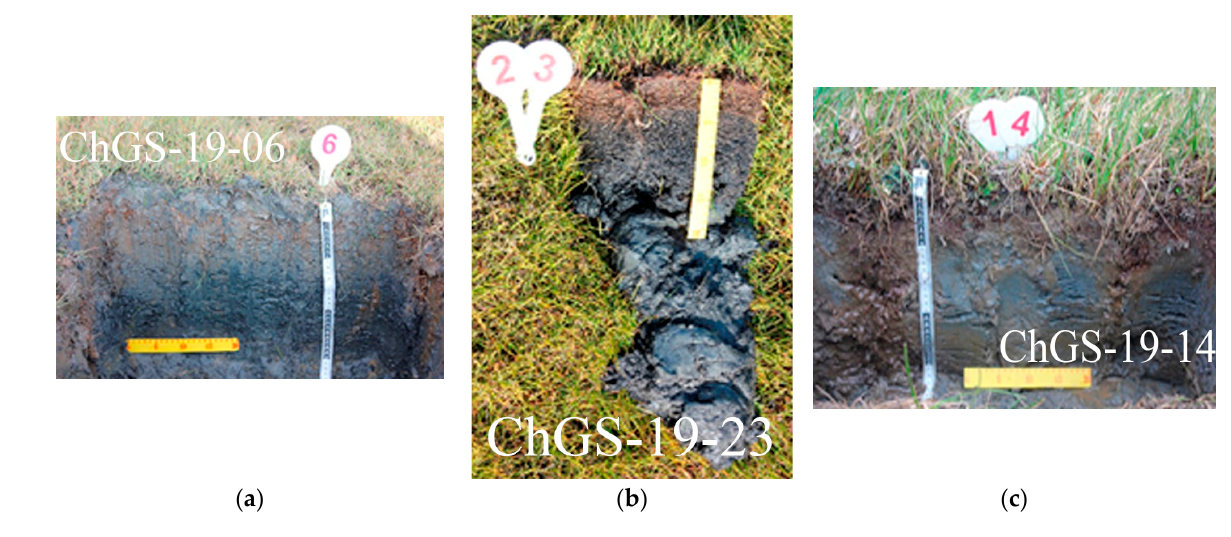
Figure 2. Watt ( a , ChGS-19-06), marsh ( b , ChGS-19-23) and maritime ( c , ChGS-19-14) soil morphol-